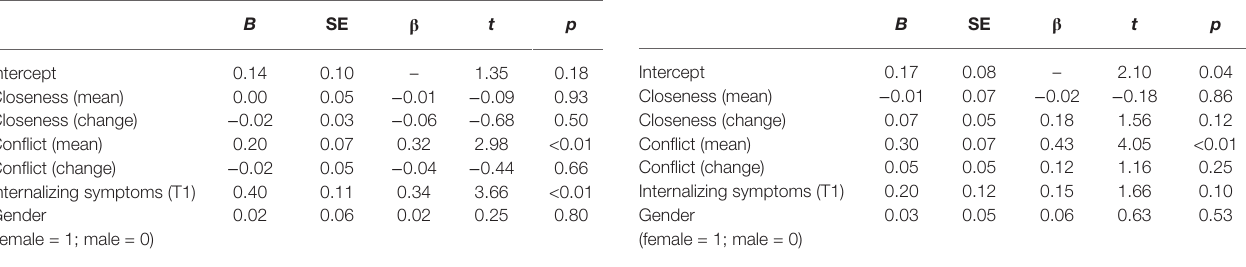
TABLE 5 | From primary to middle school: T2 internalizing symptoms on TABLE 3 | From kindergarten to primary school: T2 internalizing symptoms on student-teacher relationship scale variables ( N = 97, R 2 = student-teacher relationship scale variables ( N = 104, R 2 = 0.30). B